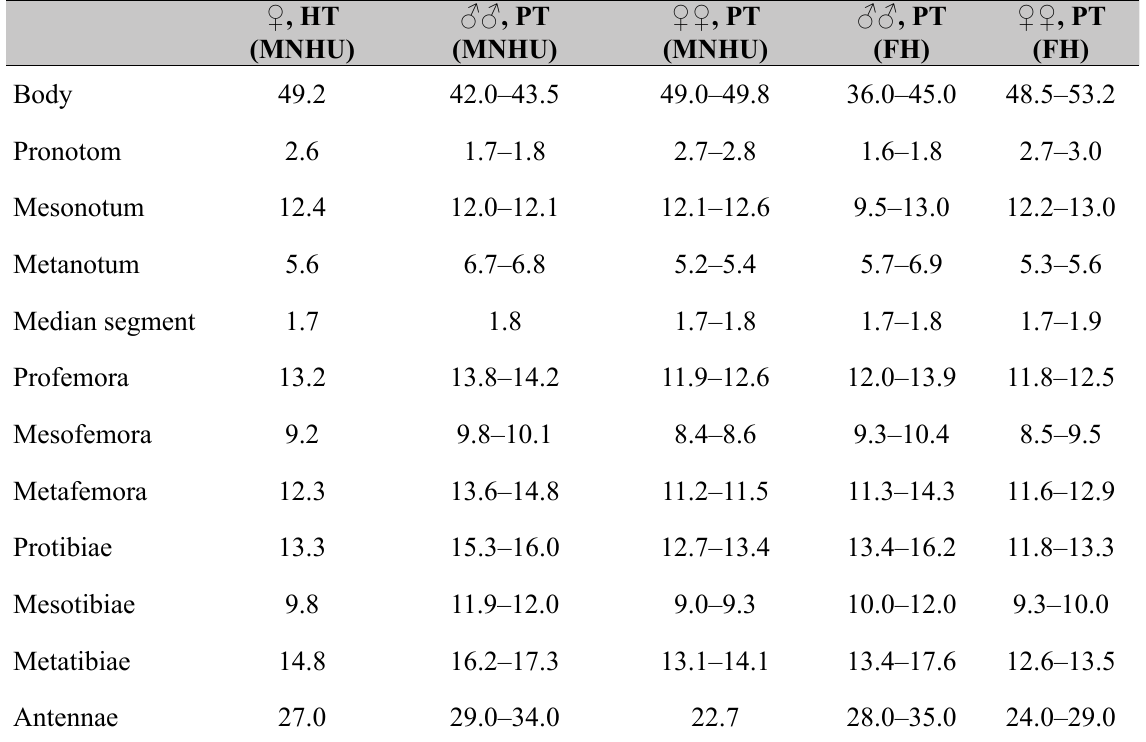
Table 1. Measurements of L. carbonelli sp. nov. (in mm). HT = holotype; PT =